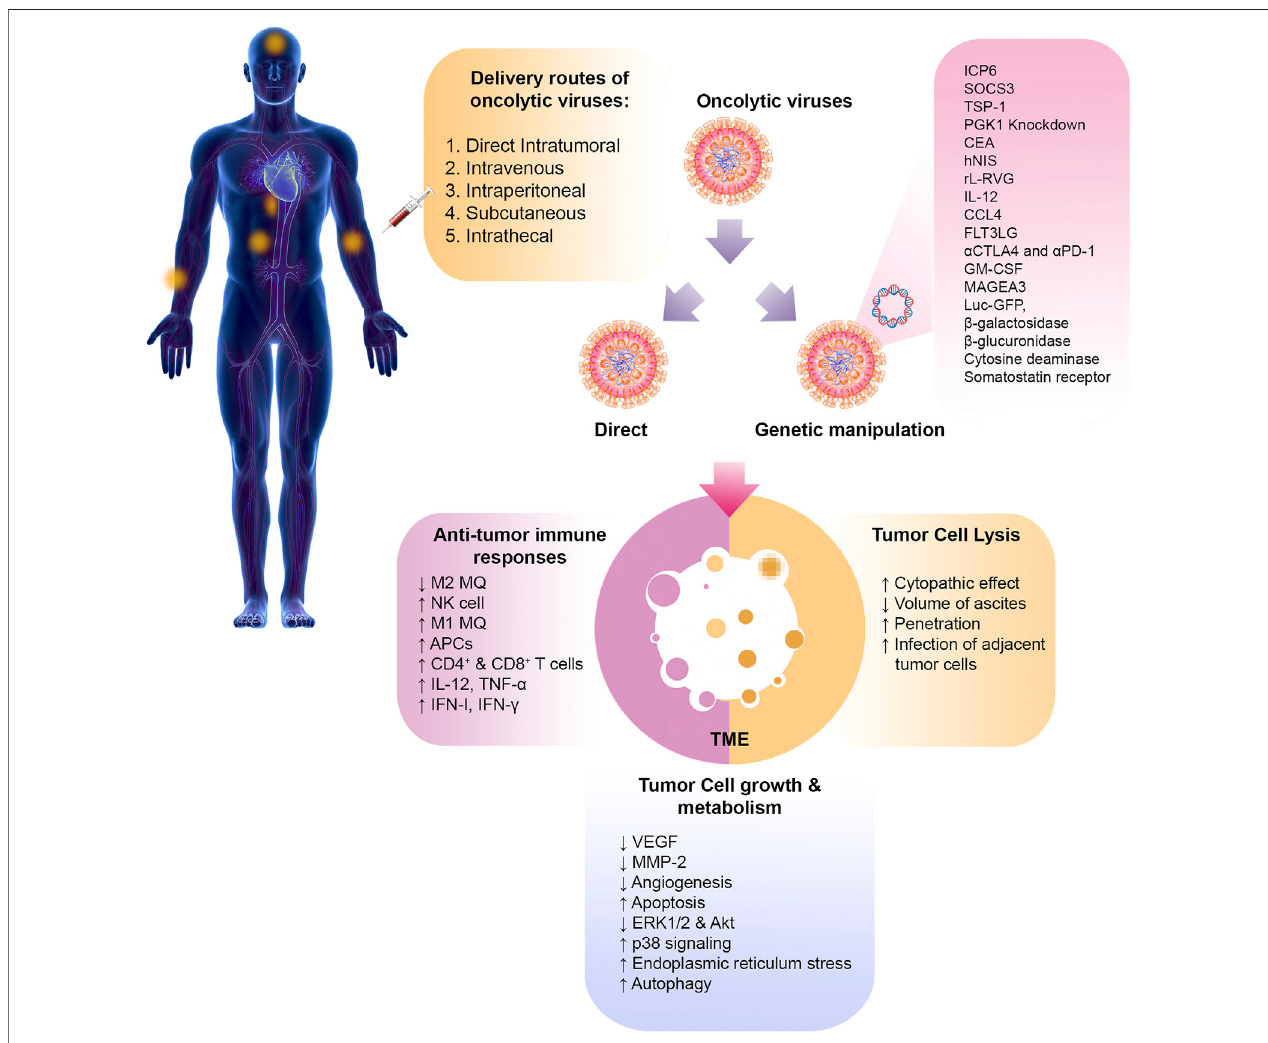
FIGURE 2 | Oncolytic virotherapy of cancer. The various routes of oncolytic virus delivery are shown. Oncolytic viruses can be manipulated through genetic engineering to express speci fi c genes or administered directly without modi fi cation. Once they reach the tumor site, these viruses can directly cause lysis of tumor cells. They can also help remove the tumor by altering the immunosuppressive TME and inducingantitumor effector immune cells. Other mechanisms, such as angiogenesis, apoptosis, and autophagy, can also be altered by oncolytic viruses. PMGC, peritoneal metastasis of gastric cancer; SOCS3, suppressor of cytokine signaling 3; TSP-1, thrombospondin-1; PGK-1, phosphoglycerate kinase-1; CEA, carcinoembryonic antigen; hNIS, human sodium iodide symporter; rL-RVG, rabies virus glycoprotein; HSV, herpesvirus; 5-FU, 5- fl uoro-uracil; PTX, paclitaxel; NDV, Newcastle disease virus; MQ, macrophage; VEGF, vascular growth factor; MMP-2, matrix metalloproteinase-2; FLT3LG, Fms related receptor tyrosine kinase 3 ligand; CTLA4, cytotoxic T-lymphocyte-associated protein 4; PD-1, programmed cell death-1; GM-CSF,granulocyte-macrophagecolony-stimulatingfactor;MAGEA3,melanoma-associatedantigen3;LucGFP,luciferasegreen fl uorescentprotein;IFN,interferon; TNF, tumor necrosis factor; APC, antigen presenting